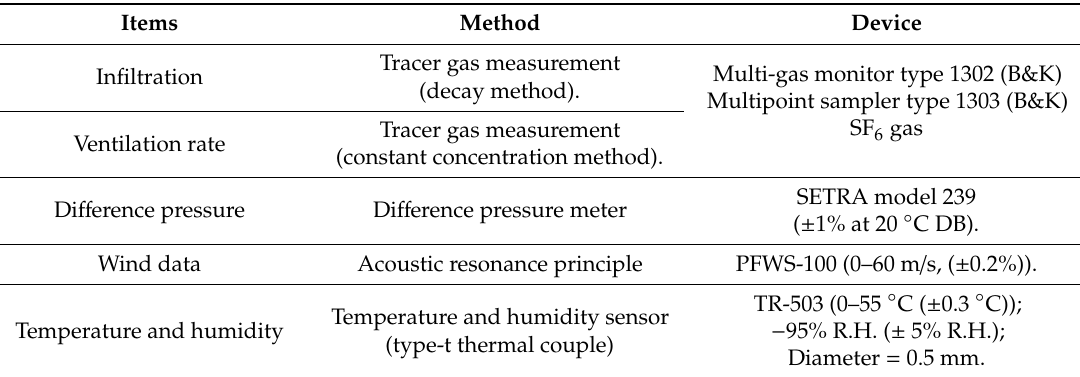
Table 1. Details of the measured items. 135